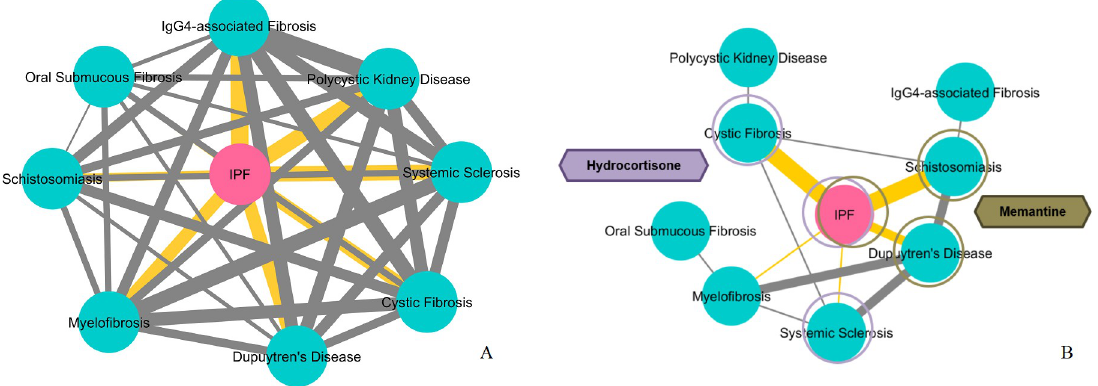
Fig 5. Disease similarity networks based on common pathways and repurposed drugs. A. Similarity network among the 9 fibrotic diseases based on their common pathways as produced by the PathWalks algorithm. IPF does not have any unique pathway nodes at the top- 5 % of its PathWalks results. IPF has the most common pathways with IgG4-related Disease ( 14 /15) and the least with OSF ( 8/15 ). The edge thickness is relative to the number of common pathways between any 2 diseases. B. Disease-similarity network based on the common re-ranked drug candidates. The edge thickness is proportional to the number of common genes between pairs of diseases. IPF shares 3 drugs with CF and Schistosomiasis , 2 with Dupuytren’s Disease and 1 drug with SSc and Myelofibrosis . The fact that IPF shares 2 or 3 drugs with each of CF , Schistosomiasis and Dupuytren’s Disease is statistically significant based on a hypergeometric test. SSc and Myelofibrosis each share only 1 re-ranked drug with IPF , an event that might occur due to randomness. Hydrocortisone is highlighted by the re-ranking procedure for IPF , CF and SSc while memantine is highlighted in the use cases of IPF , Dupuytren’s Disease and Schistosomiasis